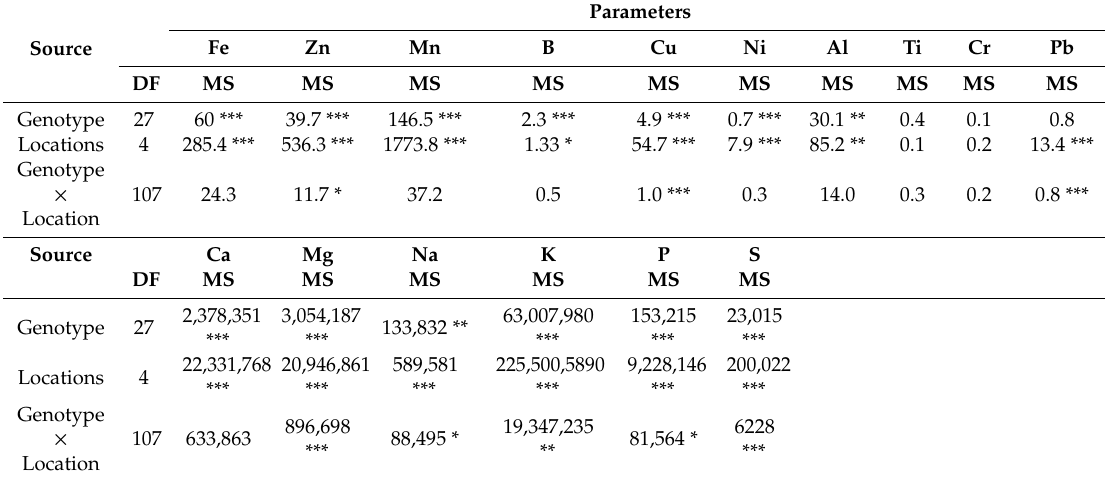
Table 2. Mean squares (MS) of analysis of variance (ANOVA) for trace and macroelements of yellow-fleshed cassava roots across five growing